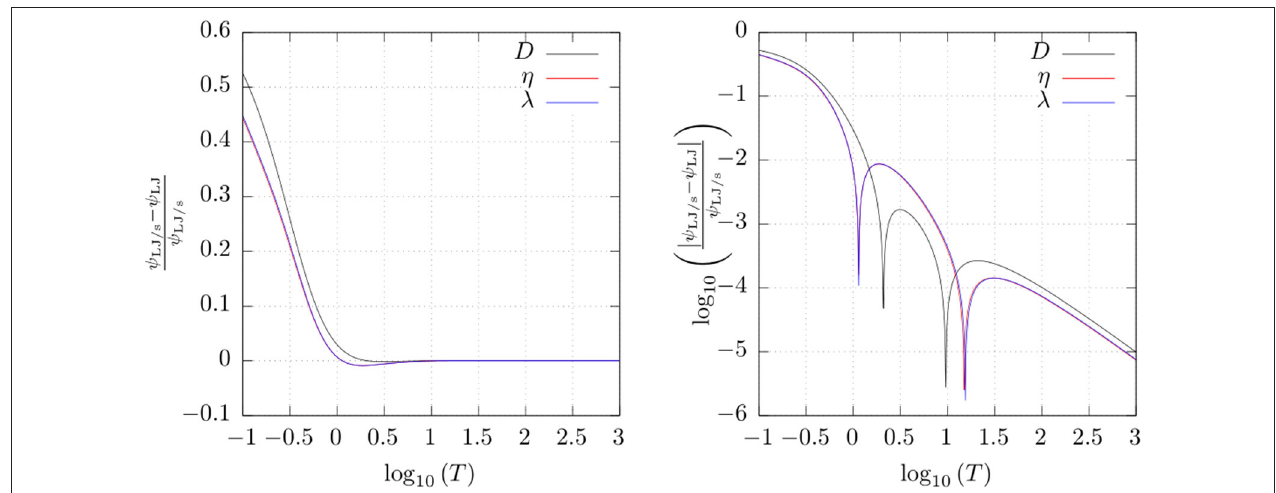
D , η , λ of the Lennard-Jones and Lennard-Jones/spline fluids at different temperatures T , where D is the FIGURE 6 | Comparison of the transport coefficients ψ = self-diffusion coefficient, η is the shear viscosity, and λ is the thermal conductivity.